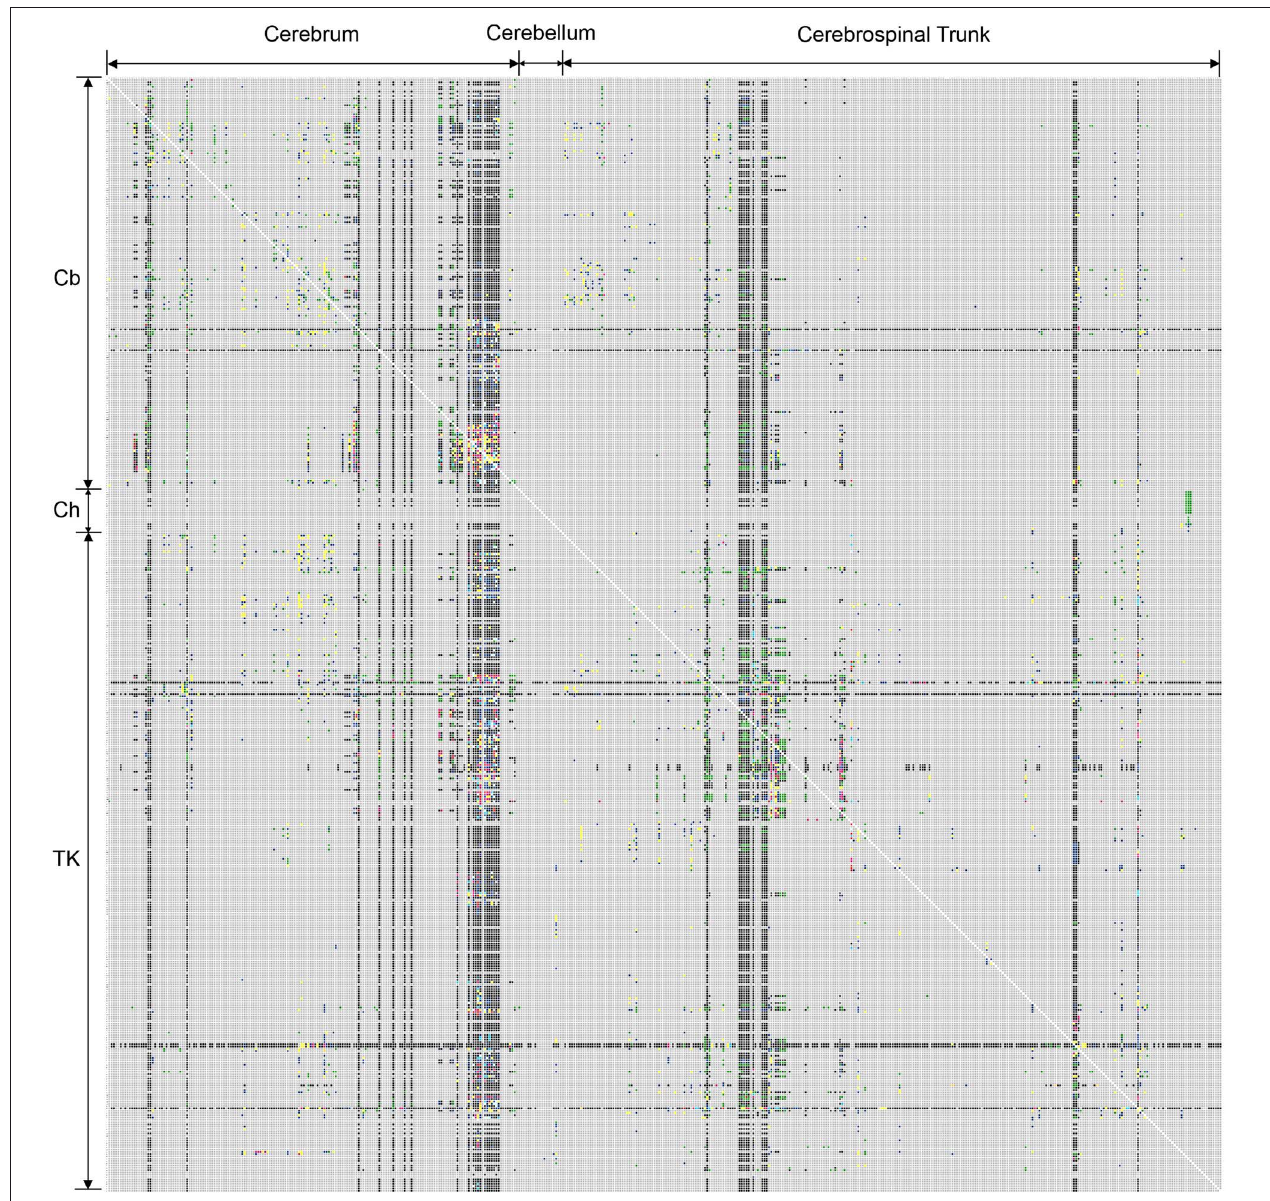
FIGURE 1 | First version of the rat CNS macroconnectome, defined in the Swanson-1998 nomenclature and constructed from data in BAMS [Bota and Swanson (2007a); Bohland et al. (2009)]. The color code used to produce both macroconnectome versions is as follows: gray—absent information; black—evidence that connection is absent; green—evidence